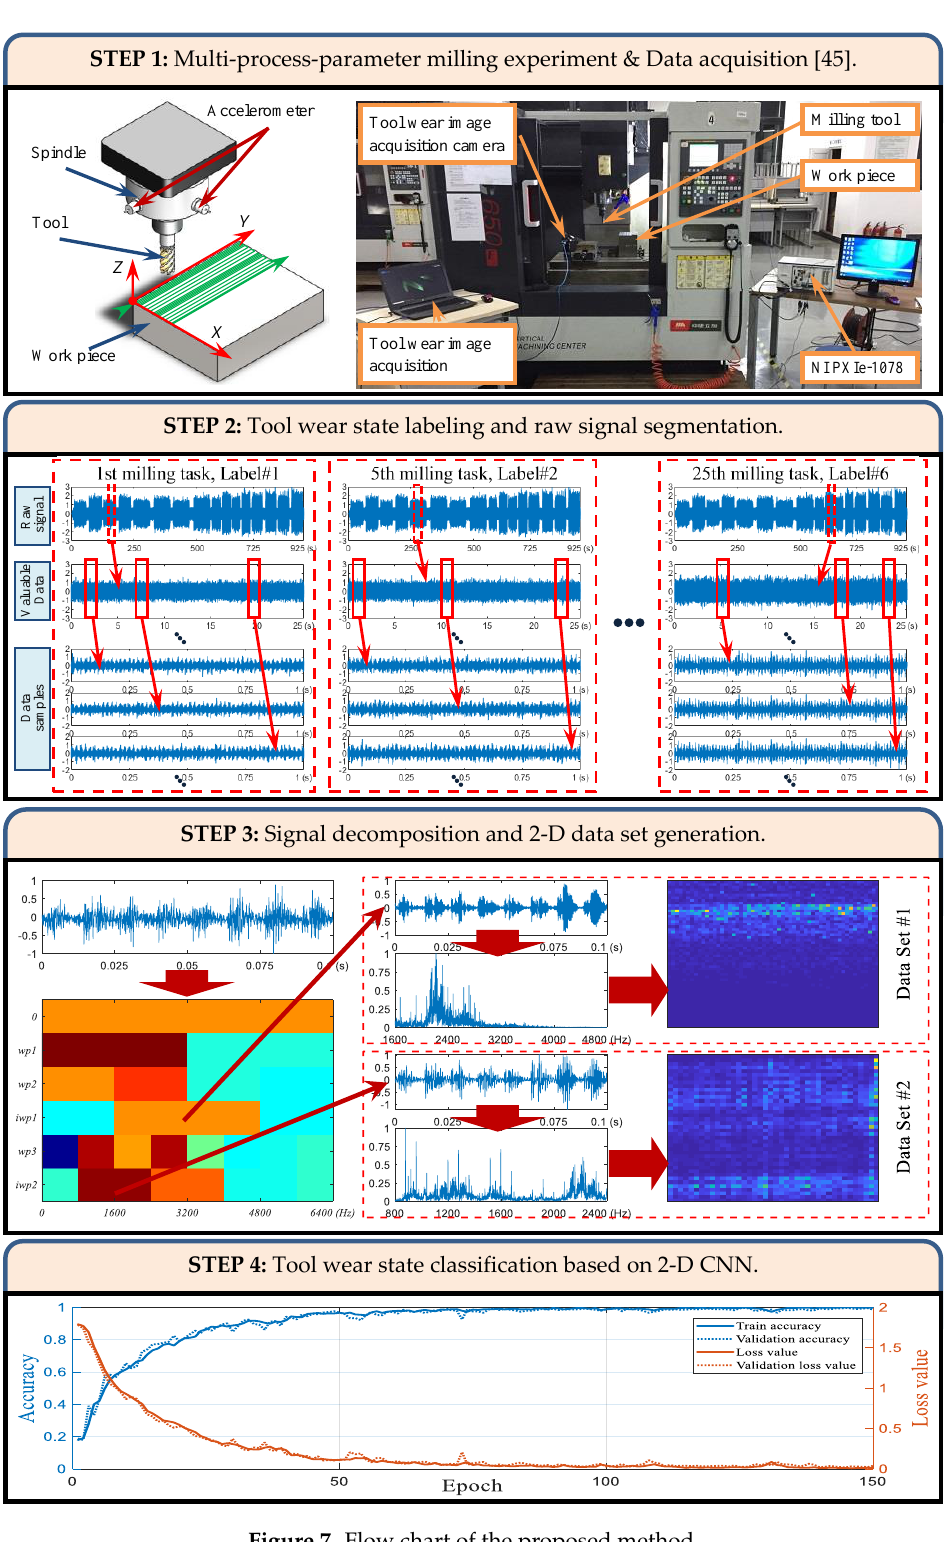
Figure 7. Flow chart of the proposed method.